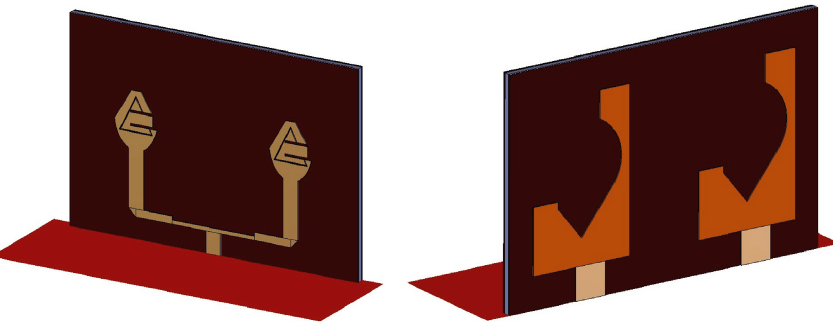
Figure 10: 3D view of the 1 × 2 antenna